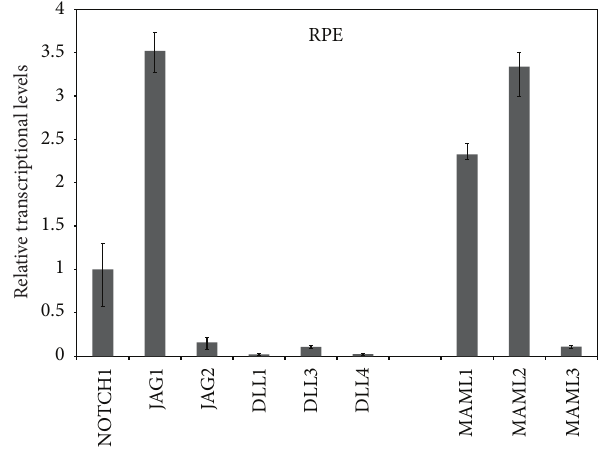
Figure 1: The members of the Notch signaling pathway components were differentially expressed in RPE cells. The relative expression levels of Notch signaling components in RPE cells were determined by real-time RT-PCR analysis. The detected components included five Notch ligands (JAG1, JAG2, DLL1, DLL3, and DLL4) and three MAML transcriptional coactivators (MAML1, MAML2, and MAML3). Error bars represent at least two independent experi-